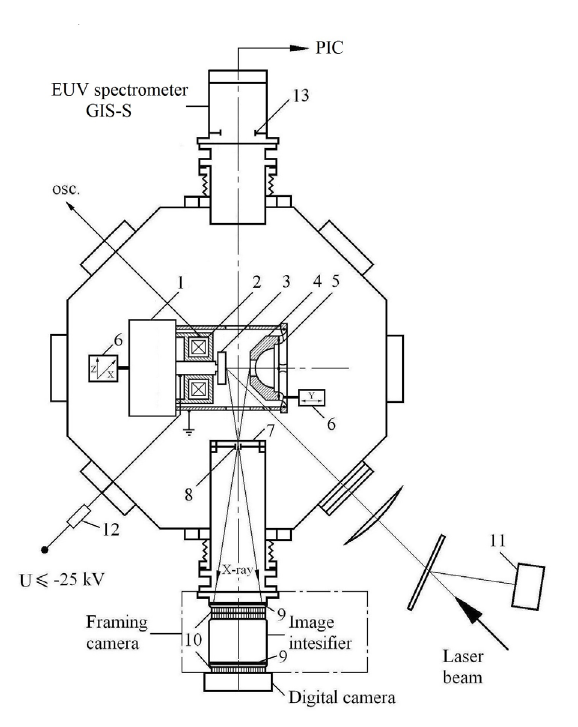
Fig.1. Experimental set-up. (1) capacitor; (2) Rogowski coil; (3) planar Al cathode; (4) anode; (5) flexible power input; (6) movable holders; (7) X-ray absorber; (8) pinholes; (9) MCP; (10) fiber optical interface; (11) calorimeter; (12) charging resistance of 100 МΩ ; (13) entrance slit of EUV